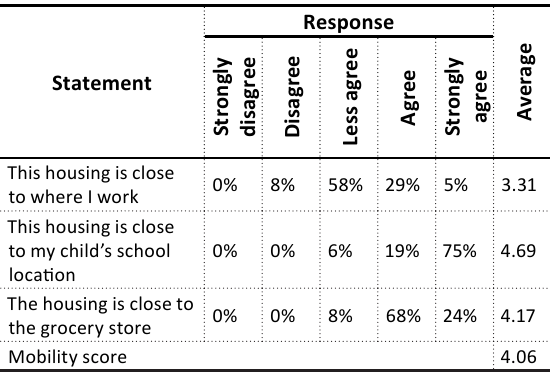
Table 6. Environment construct